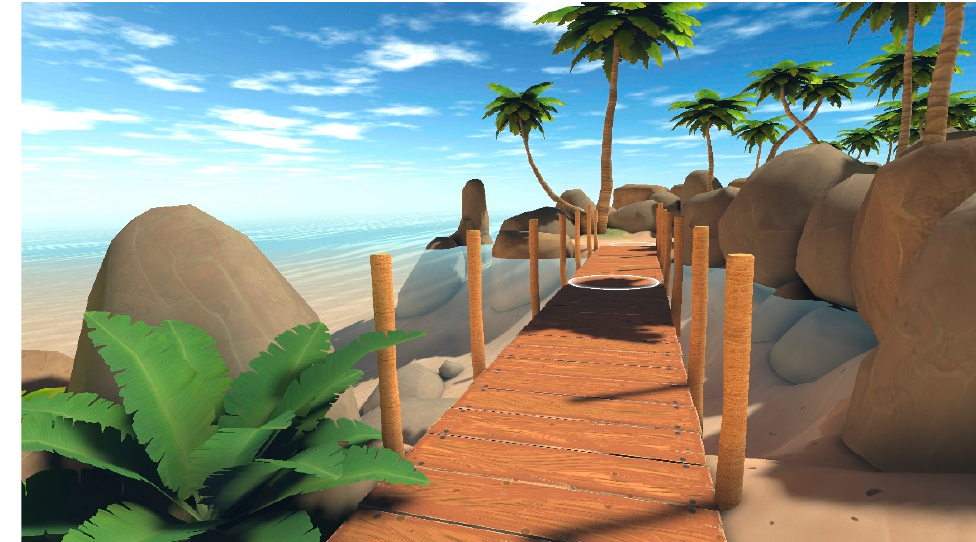
Figure 1. The MIND-VR virtual island.